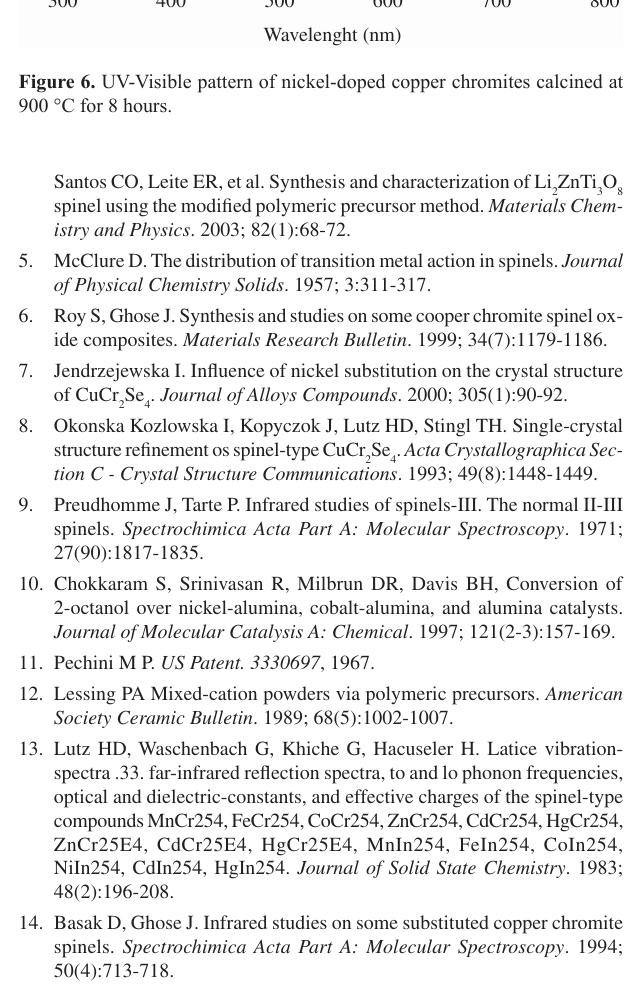
Figure 5. Infrared absorption pattern of the polymeric precursor and powders calcined at 500 (cid:111) C, 700 (cid:111) C, and 900 °C for 4 hours.